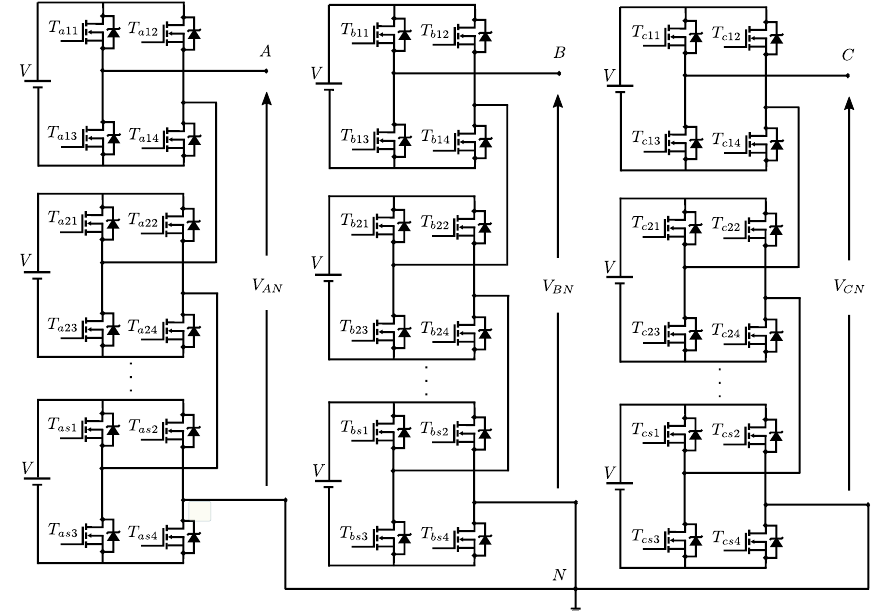
Figure 1. Three-phase cascaded H-bridge (CHB) l -level inverter